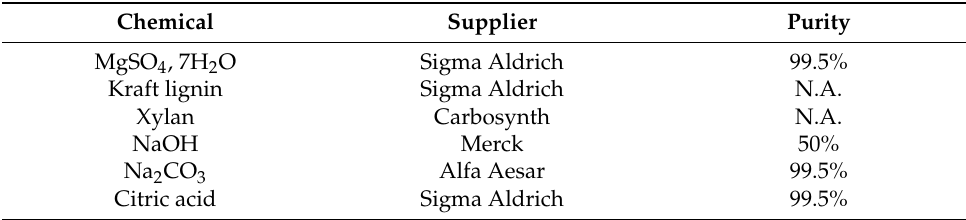
Table 1. List of Chemicals used in the experiments.